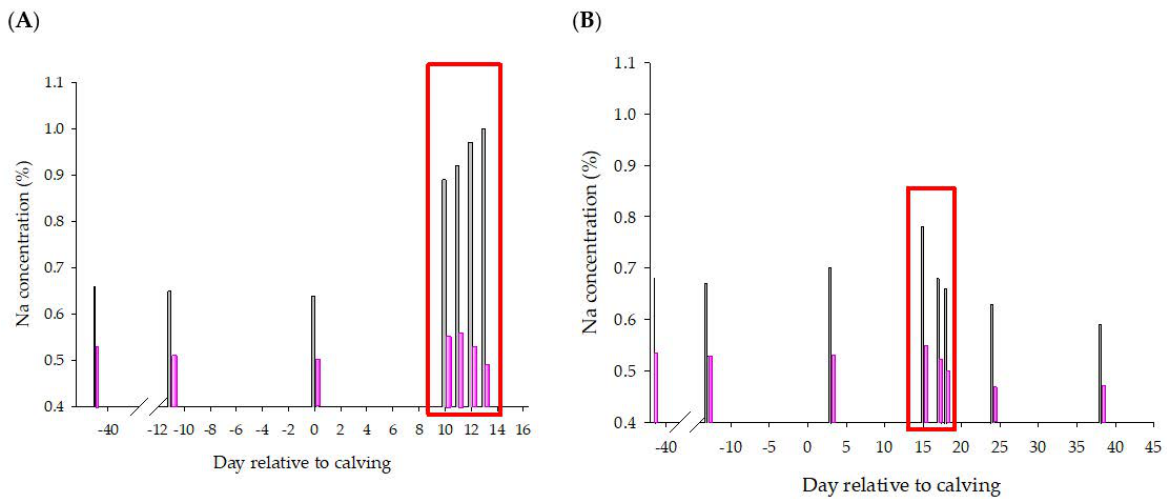
Figure 9. Osmotic resistance of two cows with periparturient hemoglobinuria (LP-PPH2, 3739 ( A ) and 8183 ( B )). Concentrations of NaCl solution at which 10% (open) and 90% (purple bar) of hemolysis was induced throughout the P deprivation study. Red rectangle indicated timing of clinical